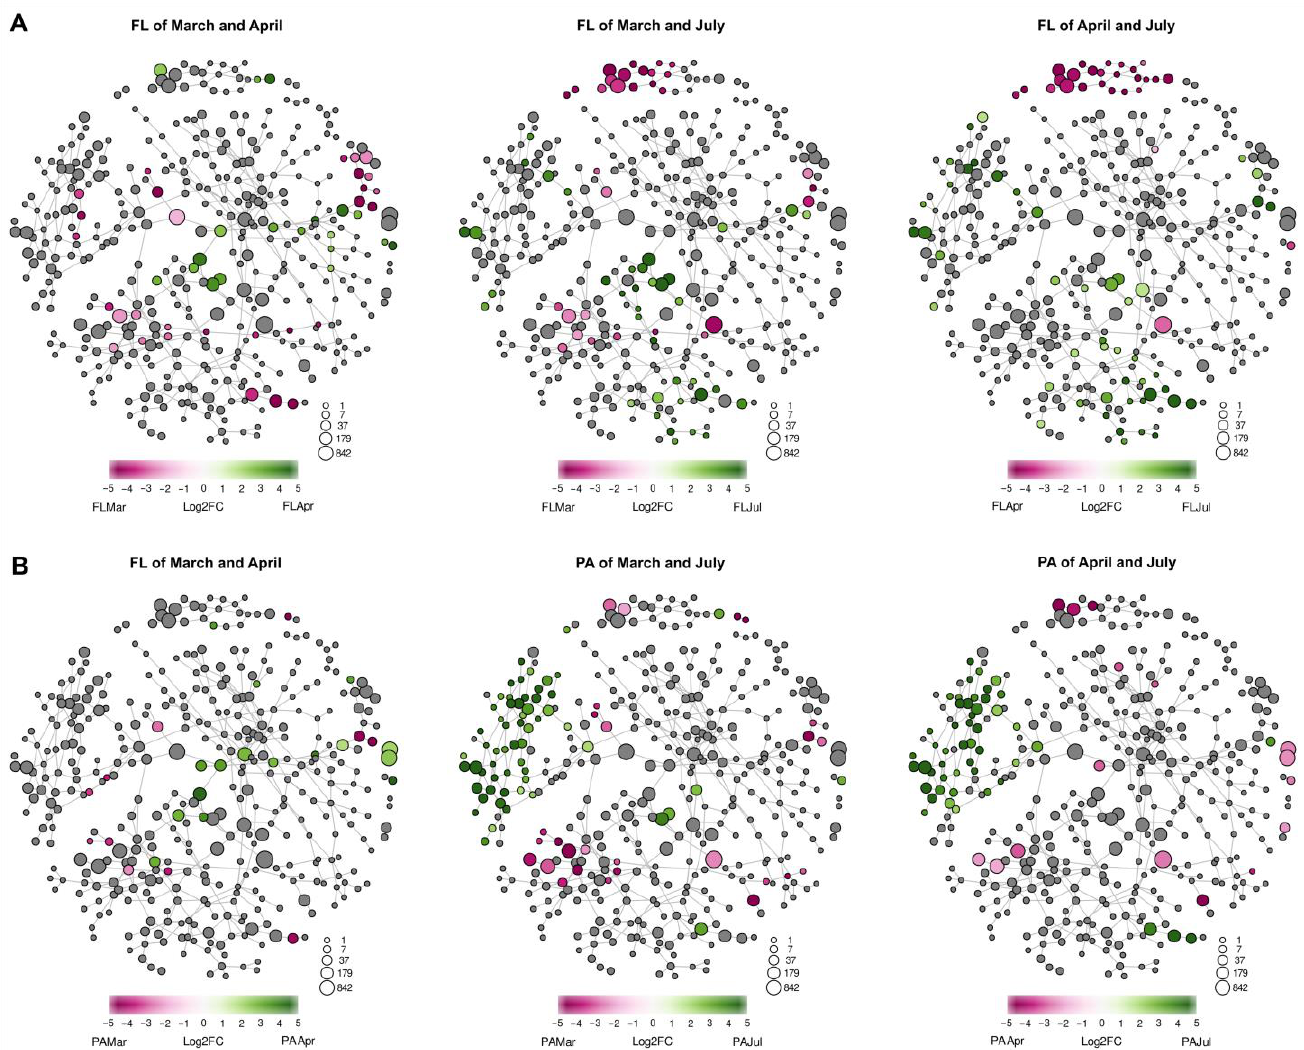
Figure 11. Co-occurrence networks of FL and PA communities. Differential abundance (DA) of community profiles colored by month log2FC in FL in March and April; in March and July; in April and July ( A ); and in PA in March and April; in March and July; in April and July ( B ). The graph layout is preserved. The size of vertex in DA-graphs is proportional to mean OTU abundance.